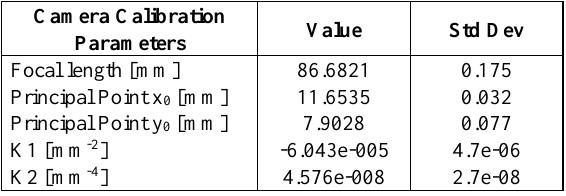
Table 2. Nikon D7100 Camera Calibration Parameters